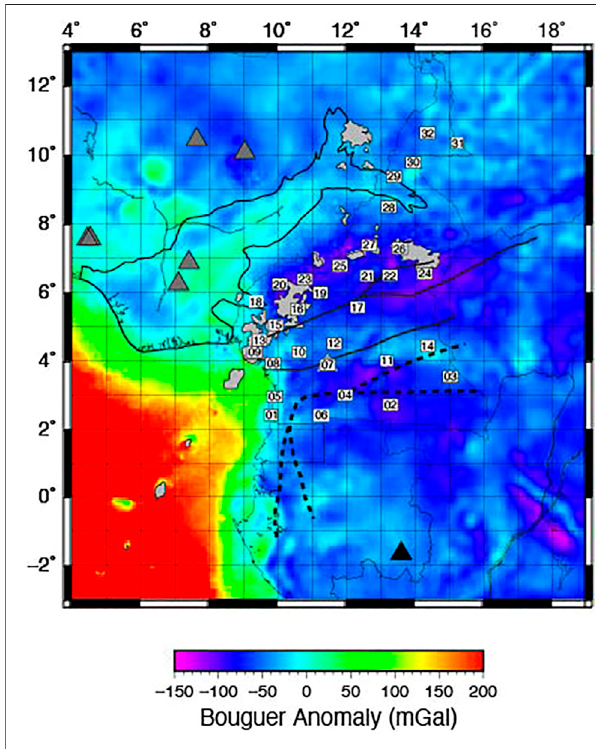
FIGURE 4 | Location of permanent (black triangle = GSN station, Albuquerque Seismological Laboratory/USGS, 1988; dark gray triangles = AfricaArray stations, Penn State University, 2004) and temporary seismic stations (white rectangles = CBSE, Wiens and Nyblade, 2005), superimposed on the bouguer anomaly from the COCE and EGM2008 combined model (GECO; Gilardoni and ReguzzoniSampietro, 2016). Numerical labels indicated station number for the CBSE. Light gray regions indicate volcanic centers, and bold lines show the borders of key regional features (see Figure 1